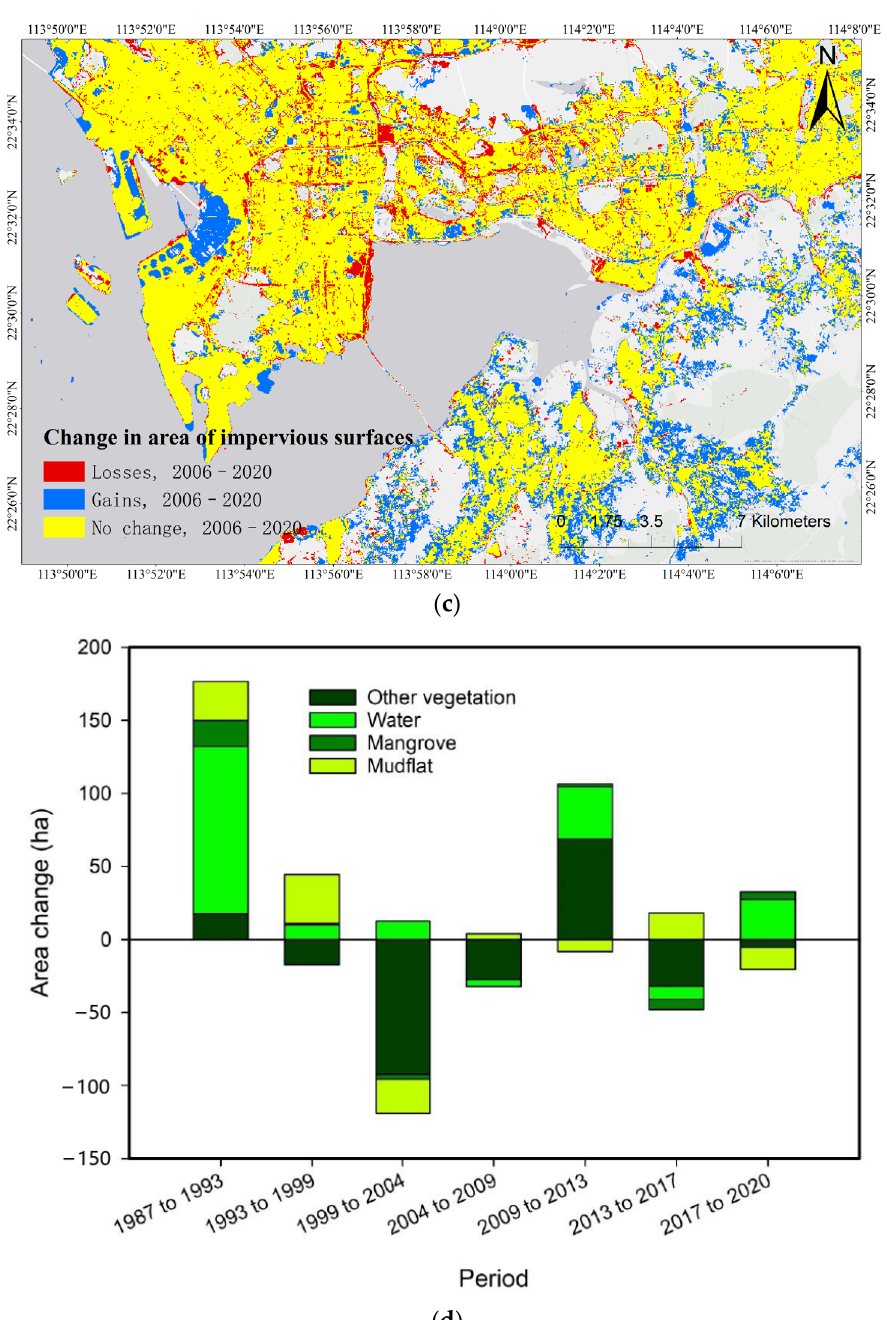
Figure 8. Impervious surfaces in Deep Bay from 1987 to 2020. ( a – c ) Change detection maps; and ( d ) Change detection statistics of impervious surfaces and other land cover types.